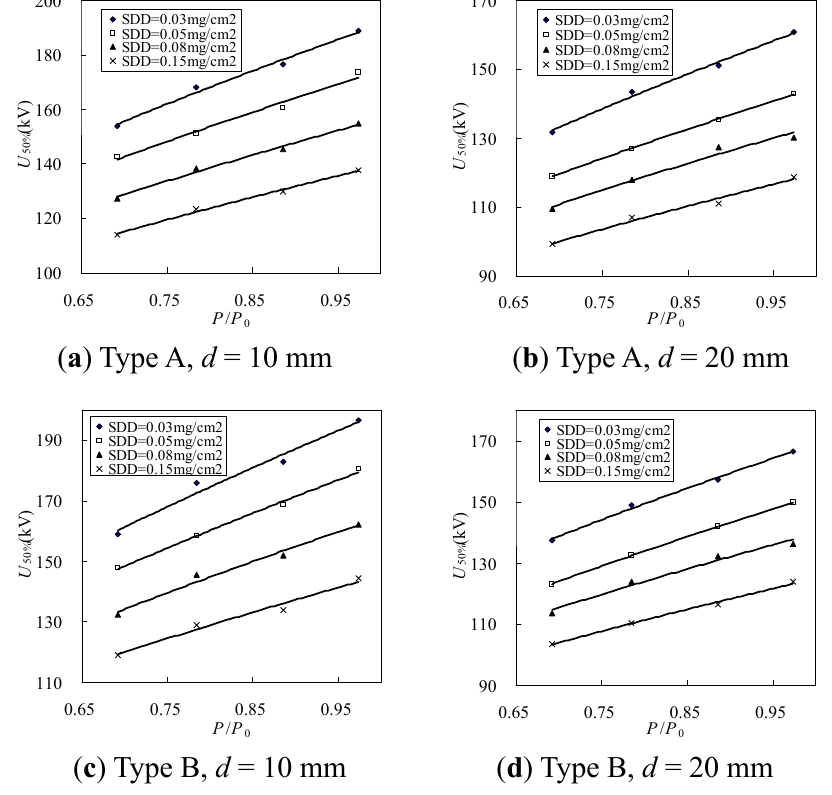
and P / P of composite insulators covered with 50% 0